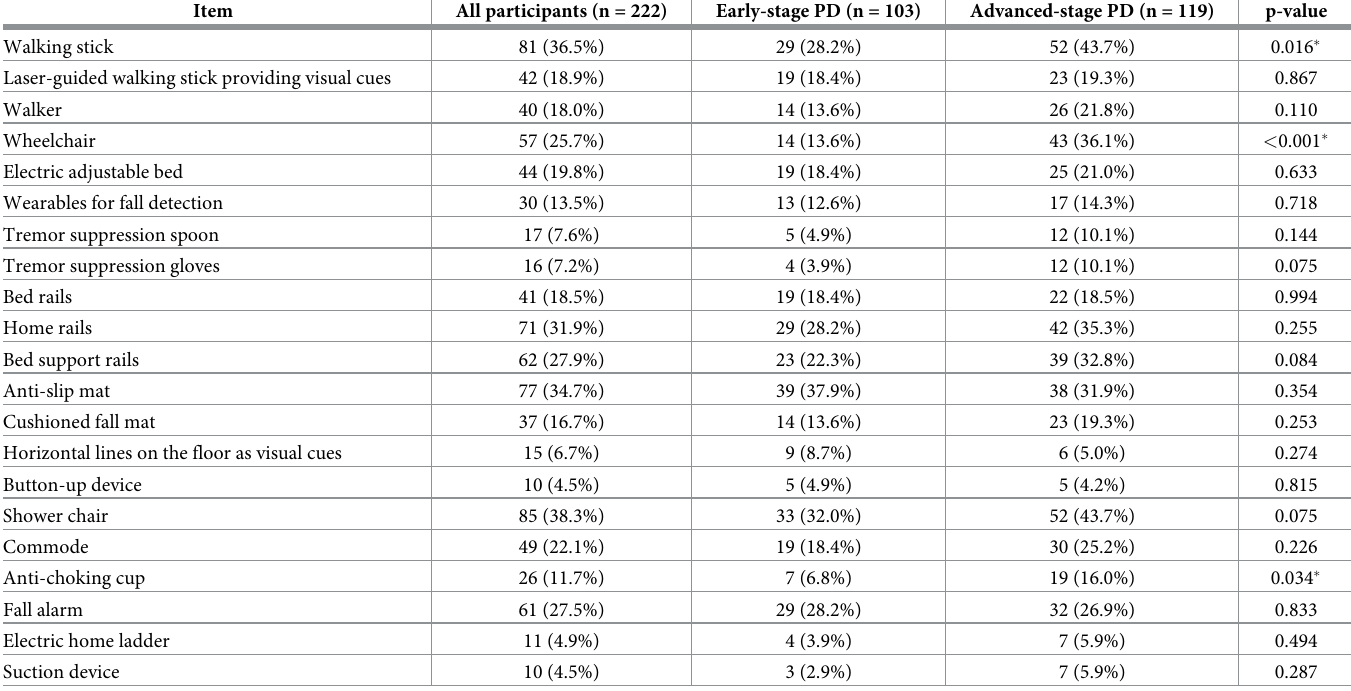
Table 6. Patients’ concerns regarding the need for assistive devices: Comparison of patients with early-stage versus advanced-stage PD. Item All participants (n =